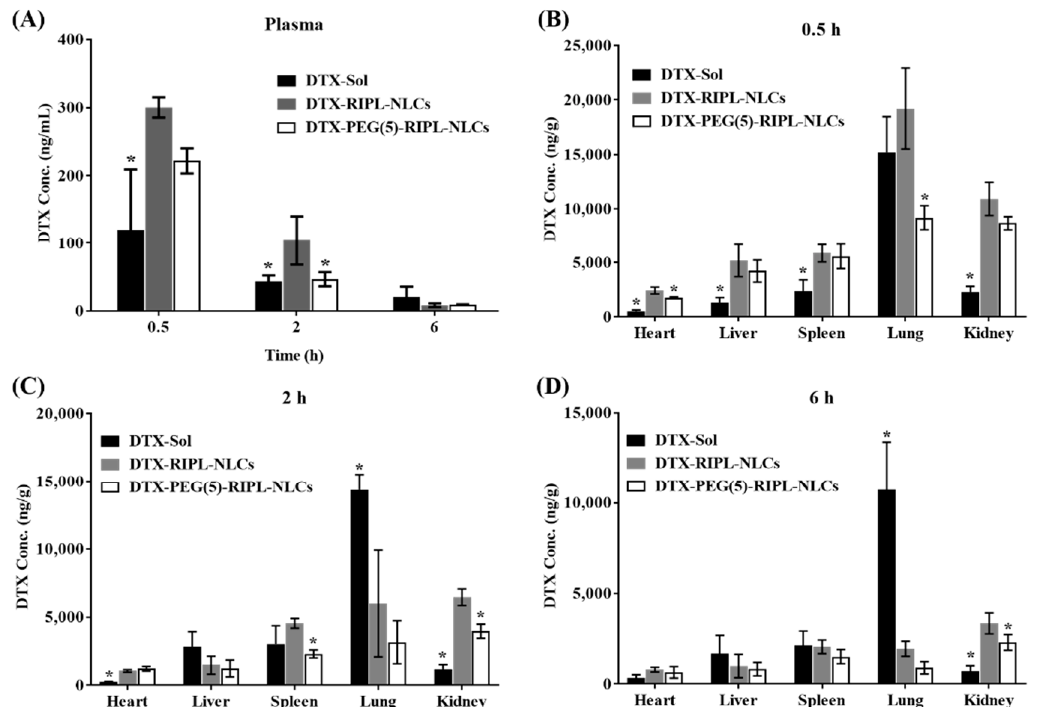
Figure 9. Biodistribution of DTX-loaded formulations in Institute of Cancer Research (ICR) mice after tail vein injection at a dose of 5 mg DTX-equivalent/kg ( ∎ : DTX-Sol; ∎ : DTX-RIPL-NLCs; □ : DTX-PEG(5)-RIPL-NLCs). Concentrations of DTX in the plasma ( A ) and representative organs are presented at different time points (0.5 h ( B ), 2 h ( C ), and 6 h ( D )). Data are the mean ± SD ( n = 5). * p < 0.05 versus DTX-RIPL-NLCs.